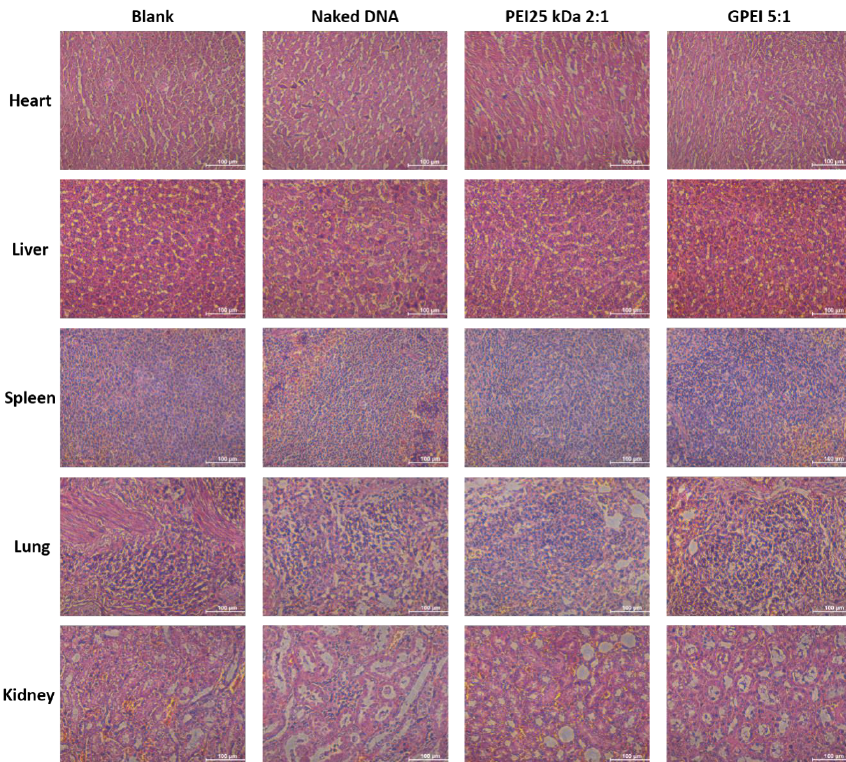
Figure 7. Hematoxylin–eosin (HE)-staining images of main organs. Bars = 100 μm.